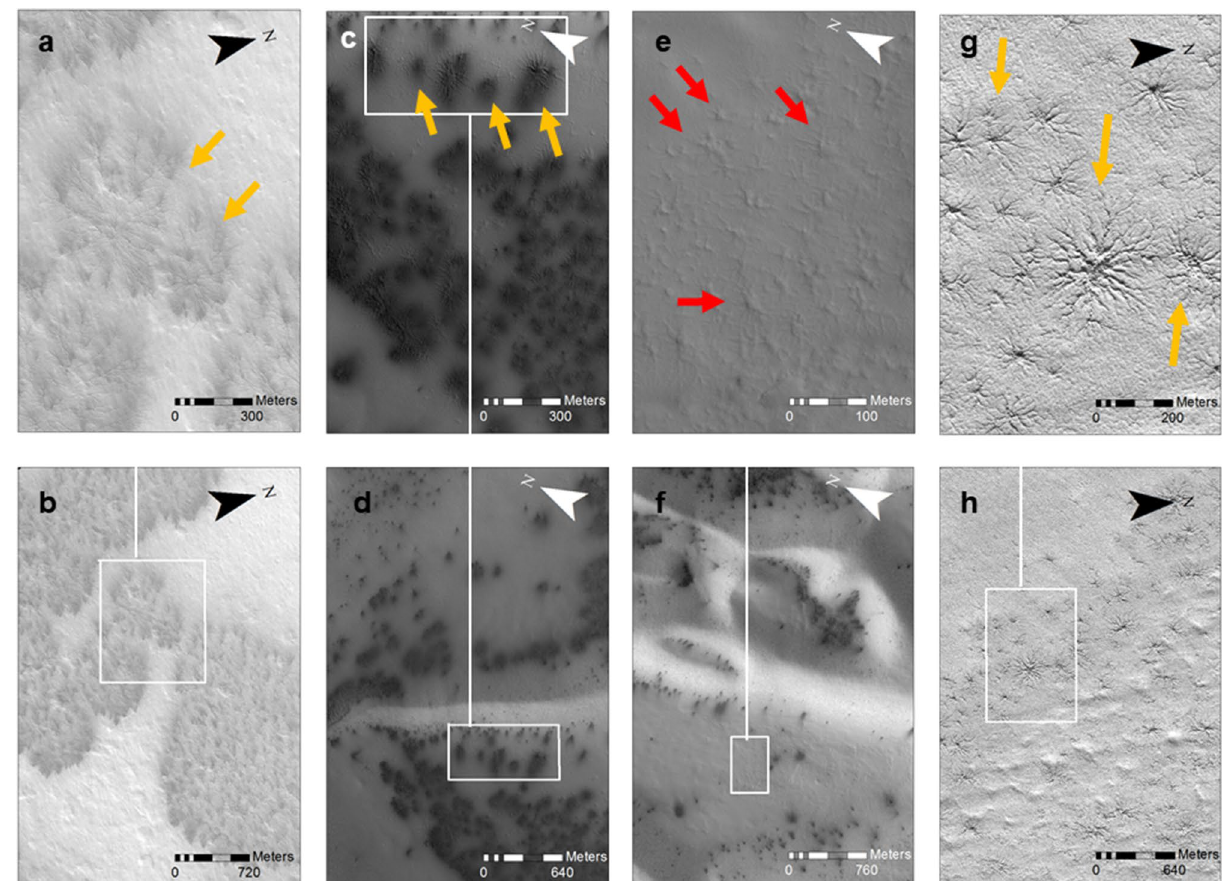
Figure 1. Zoomed and corresponding context images of a variety of araneiform morphologies ( a , b ) HiRISE image ESP _011486_0980 shows ‘Starburst araneiforms’ which are huge features. Central lat = − 81.8 ◦ ◦ lon = 76.17 , L s = 187.3 . ( c , d ) HiRISE image ESP _011491_0985 shows seasonal dark albedo fans and ◦ ◦ ◦ spots. Central lat = − 81.2 , Central lon = 296.04 , L s = 187.5 . ( e , f ) shows ‘fat spiders’ in HiRISE image ESP _014282_0930 . ( g , h ) shows close ups of ‘classic’ spiders in the same image as ( e , f ) only a different location ◦ ◦ ◦ within the site. Central lat= − 87.02 , Central lon = 86.57 , L s = 320.5 . HiRISE image credit: NASA/JPL/ University of